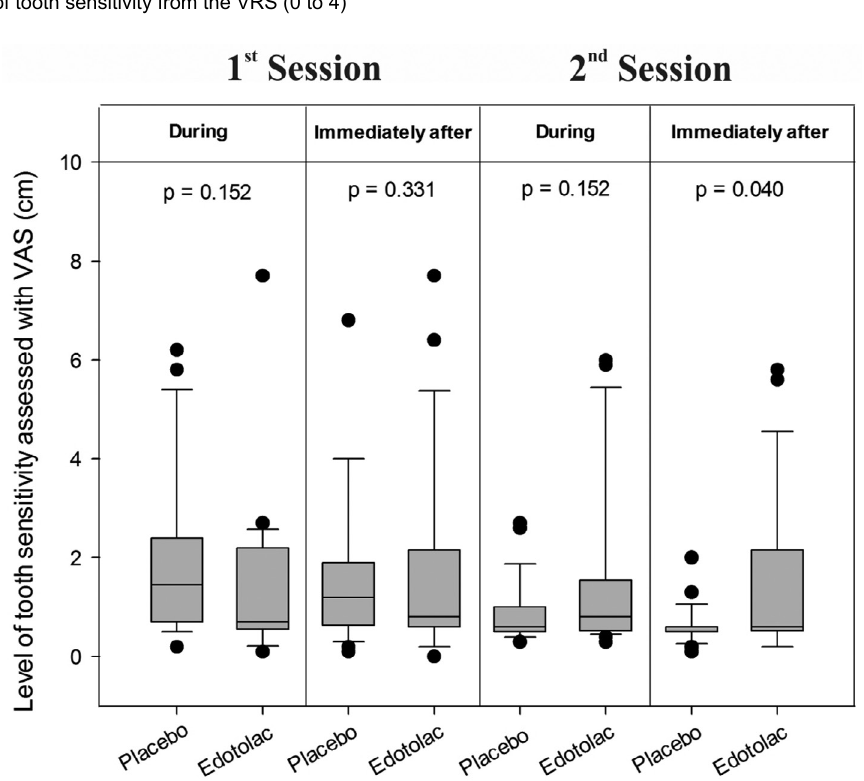
Figure 3- Level of tooth sensitivity assessed with VAS